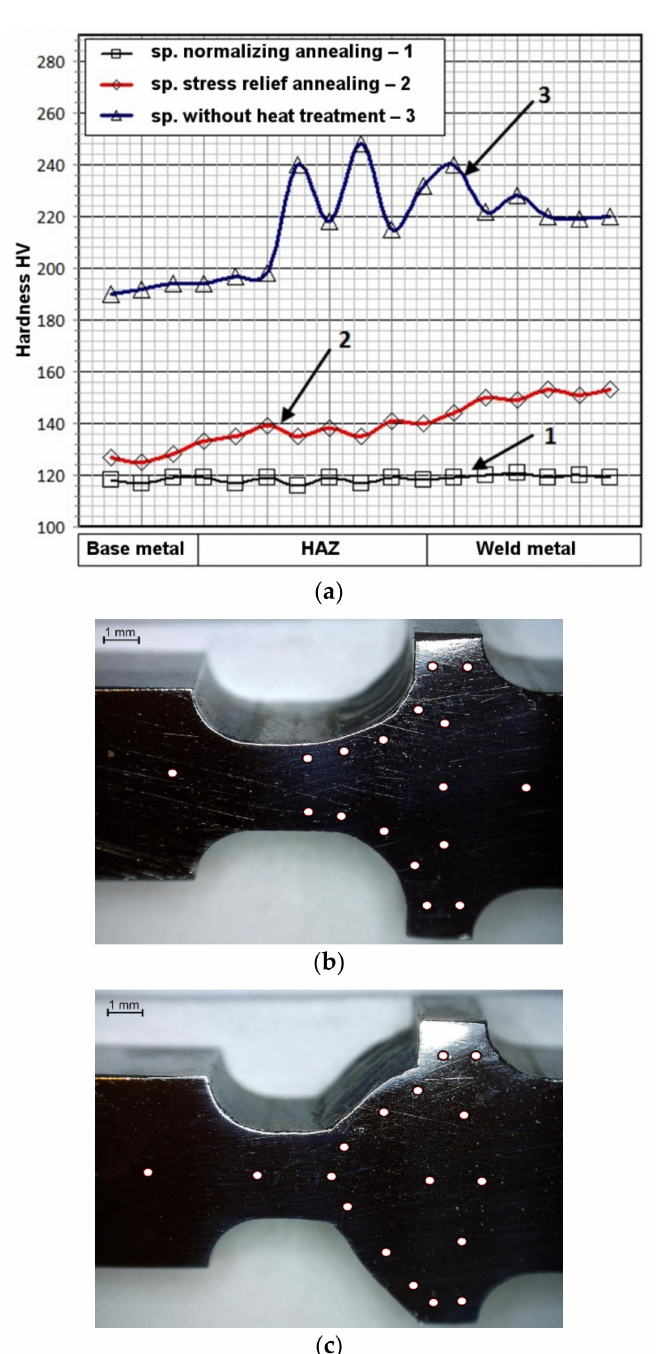
Figure 4. Hardness values including the location of the measurement in the samples, ( a ) hardness diagram; ( b ) place of measurement in strokes with concave welds; ( c ) place of measurement in strokes with convex welds. HAZ: heat-affected